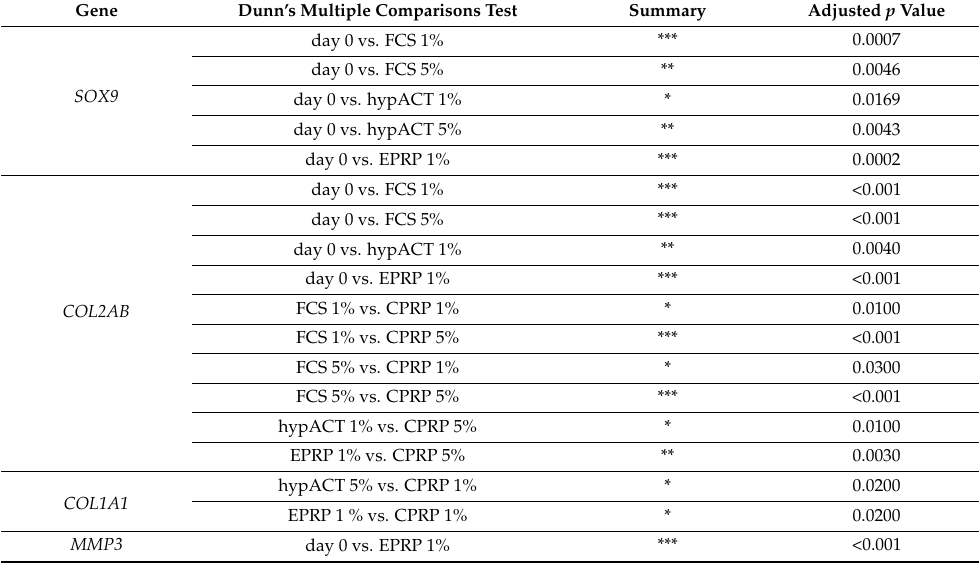
Table 2. Significant differences in gene expression between supplementation groups.